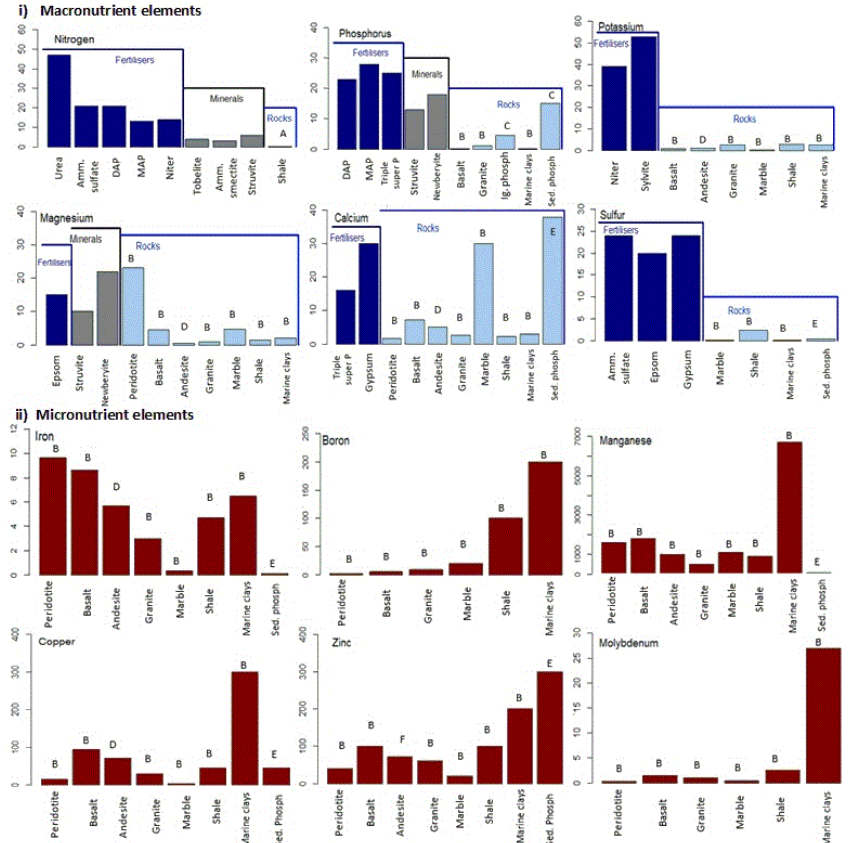
Figure 1. Typical concentrations of essential plant ( i ) macro (values in wt%) and ( ii ) micro elements (values in ppm, except iron which is wt%) across a range of prospective geological sources (minerals and rocks) for use in agriculture, with conventional fertiliser contents (“fertilisers”) for macro-elements shown for comparison. Fertiliser and mineral concentrations derived from chemical stoichiometry. DAP = diammonium phosphate, MAP = monoammonium phosphate, Amm. Smect. = ammonium